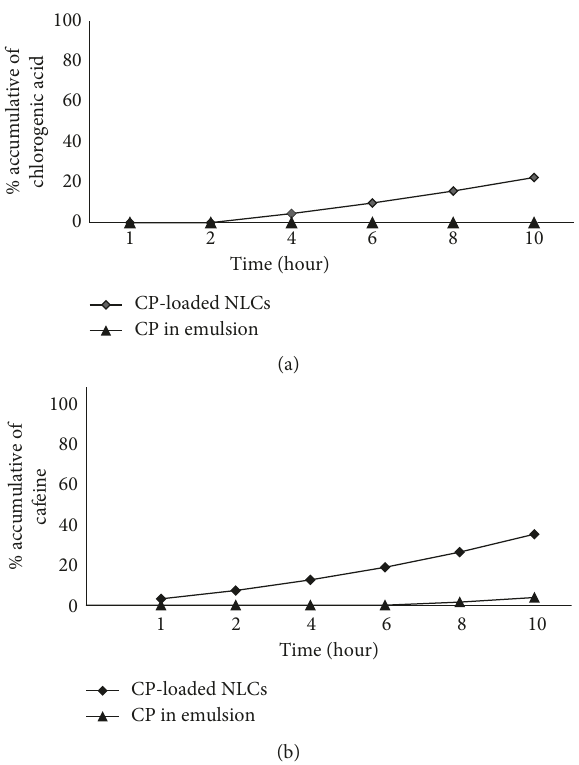
Figure 7: Percentage of accumulative amount of (a) chlorogenic acid and (b) caffeine from CP-loaded NLCs and conventional emulsion after